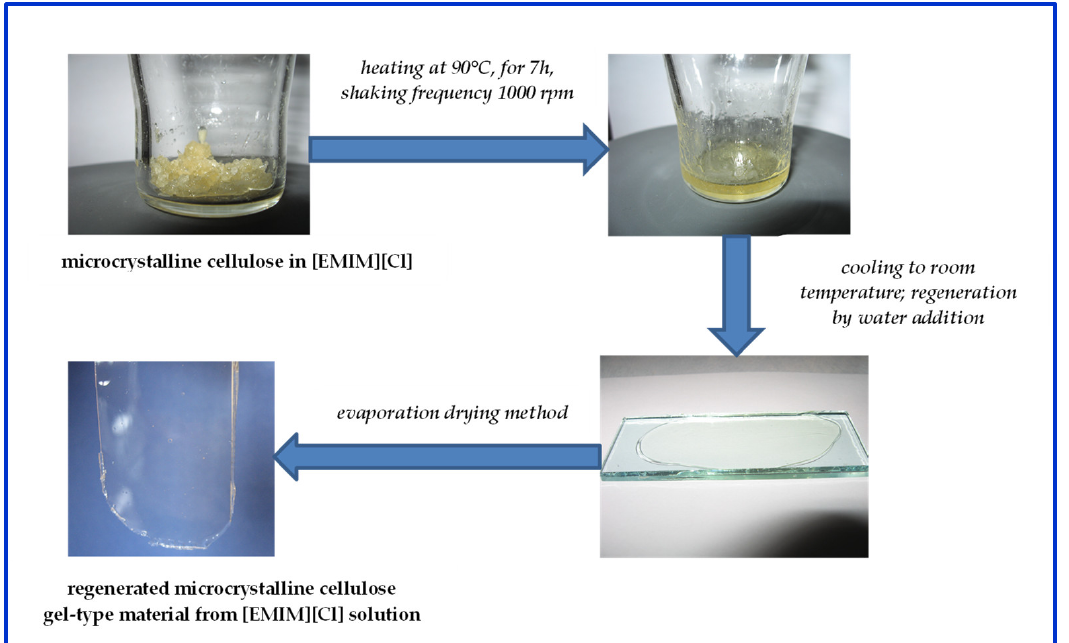
Figure 3. Microcrystalline dissolution in ionic liquid and its regeneration as transparent gel material from solution (re-drawn with permission from [208]).